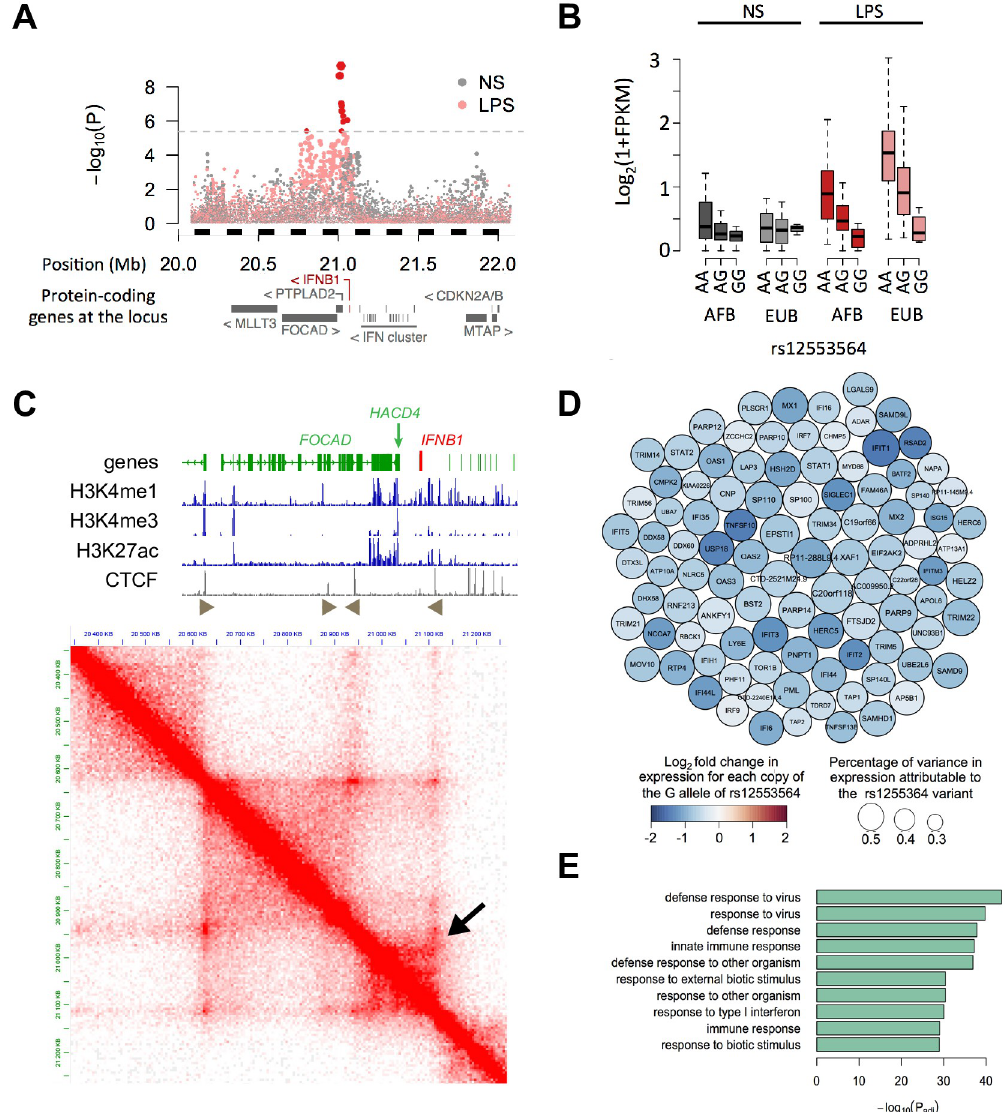
Fig 2. A genetic variant in human FIRE is associated with a decreased interferon response in myeloid cells. ( A ) Association of SNPs within 1Mb of IFNB1 with IFNB1 expression in non-stimulated (grey) and LPS-stimulated (pink) monocytes. Dotted line indicates the 1% Family wise error rate obtained by permutation. Significant SNPs are highlighted in red. ( B ) IFNB1 expression for each genotype of rs12553564 in 2 populations (AFB: African ancestry from Belgium, EUB: European ancestry from Belgium), in non-stimulated (grey) and LPS-stimulated (red) monocytes. ( C ) Hi-C analysis of the FIRE region in THP-1 cells. Genes are indicated on top, with IFNB1 in red. Histone marks of promoters (H3K4me3) and enhancers (H3K4me1 and H3K27ac) are aligned, as well as oriented CTCF peaks. The black arrow indicates the loop containing IFNB1 and rs12553564. ( D ) Top 100 genes most strongly associated to rs12553564 upon LPS stimulation. Each gene is represented by a circle colored according to the fold change in expression between both alleles of the variant. Size reflects the percentage of variance in gene expression accounted for by the variant. ( E ) Functional enrichments of IFNB1 trans–regulated genes.–Log 10 (adjusted p-values) are reported for the top 10 most enriched GO